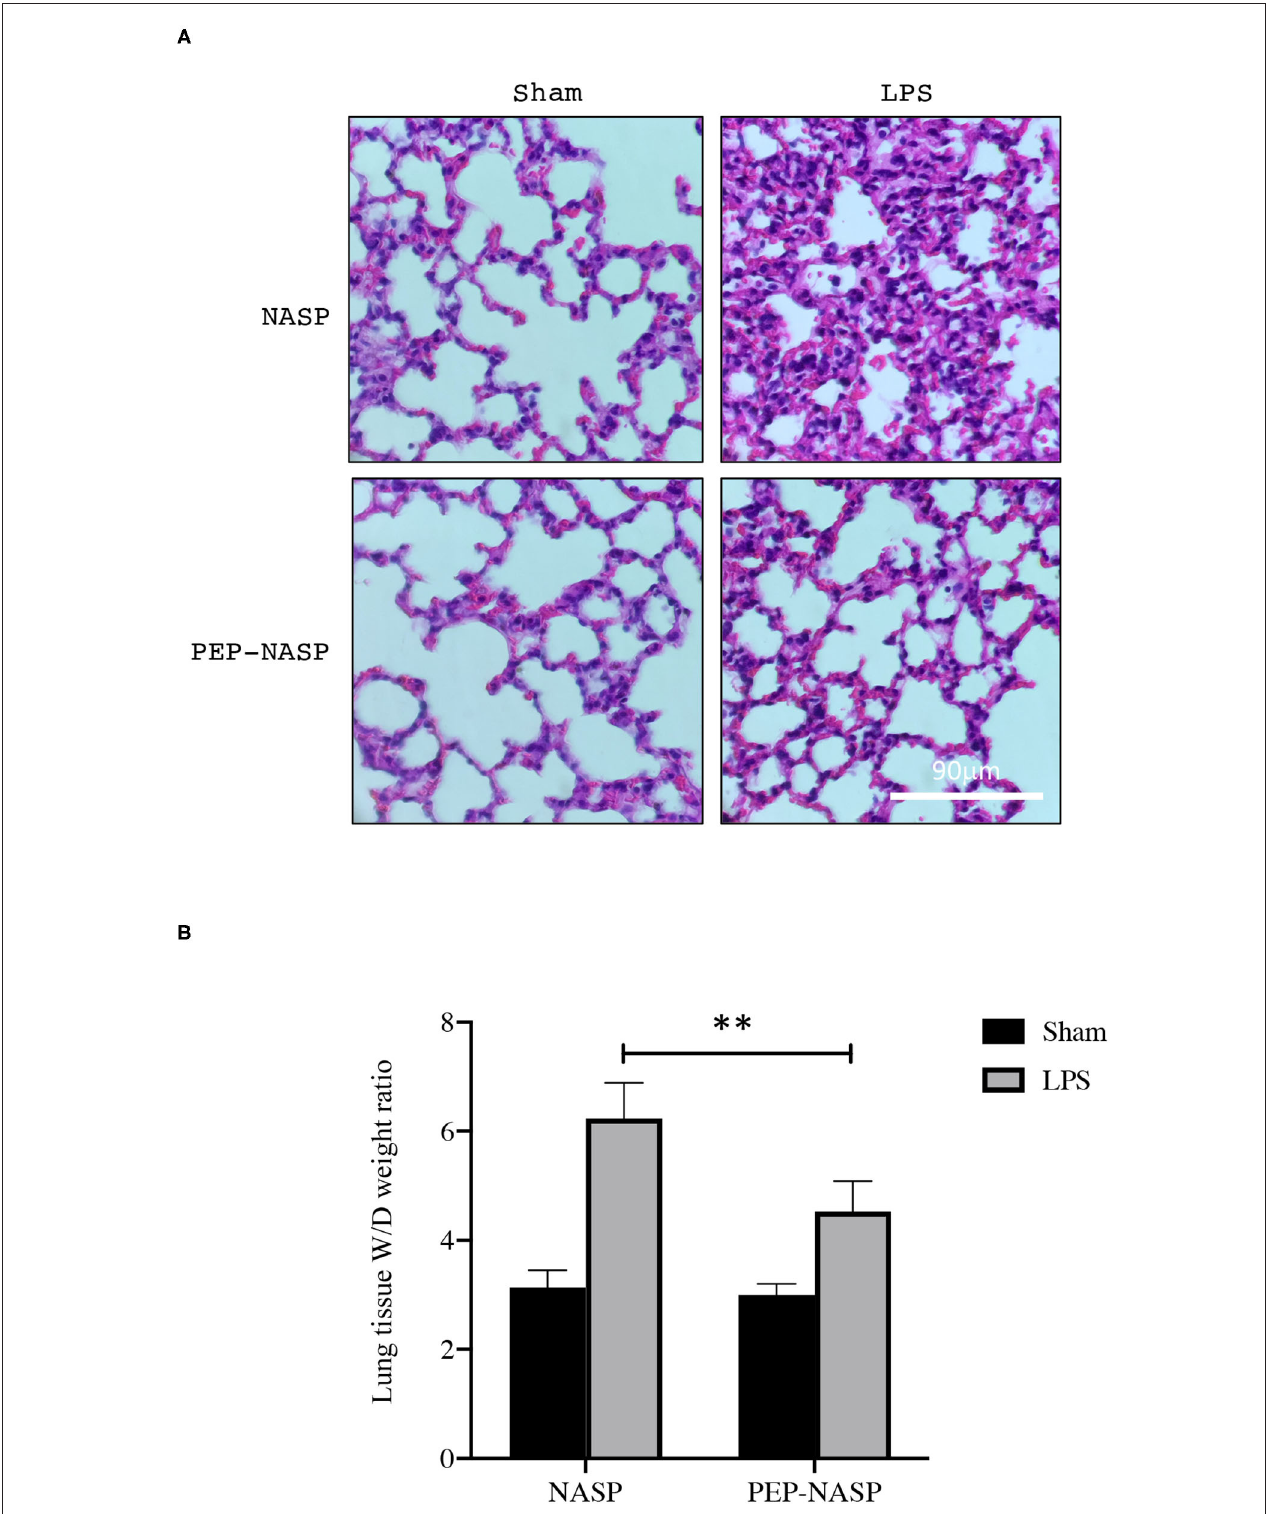
FIGURE 6 | The PEP-NASP significantly suppresses LPS-induced acute lung injury. Pathological changes in lung tissues stained with H&E. Scale bar = 90 µ m (A) , and the lung wet/dry (W/D) ratio (B) was detected in all groups. ** p < 0.01 (by a one-way ANOVA). ( n = 10 per group per experiment).